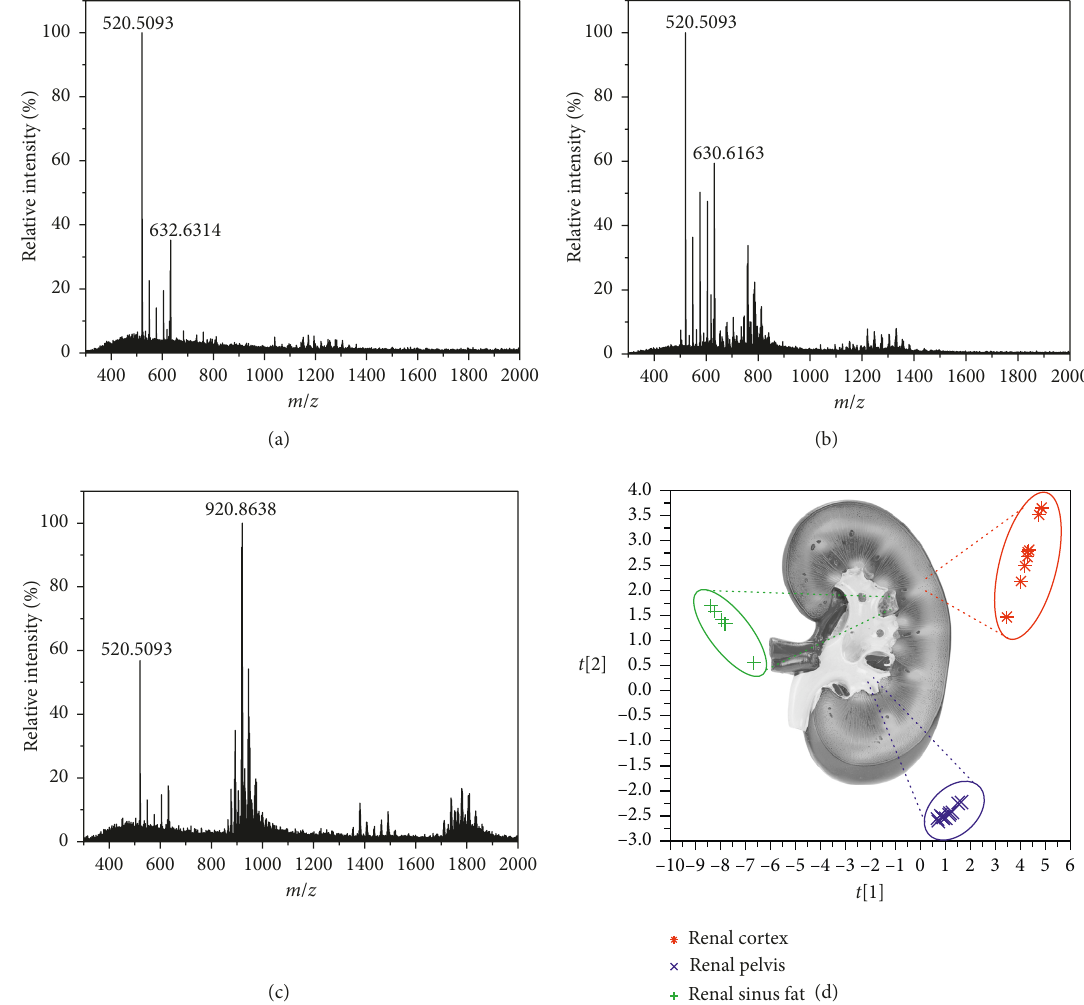
Figure 4: Typical mass spectra of (a) renal cortex, (b) renal pelvis, (c) renal sinus fat, and (d) the PCA plot, which explains 95.5% of the variance using three